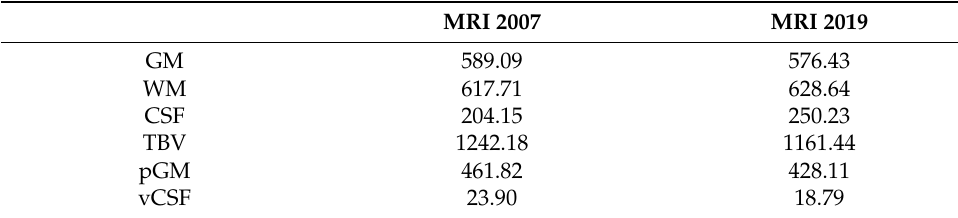
Table 1. Brain volumes from MRI